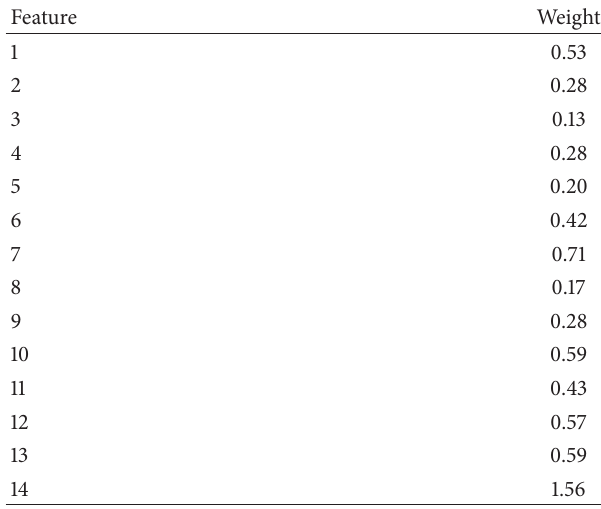
Table 3: Weight for each feature in the Wine dataset.